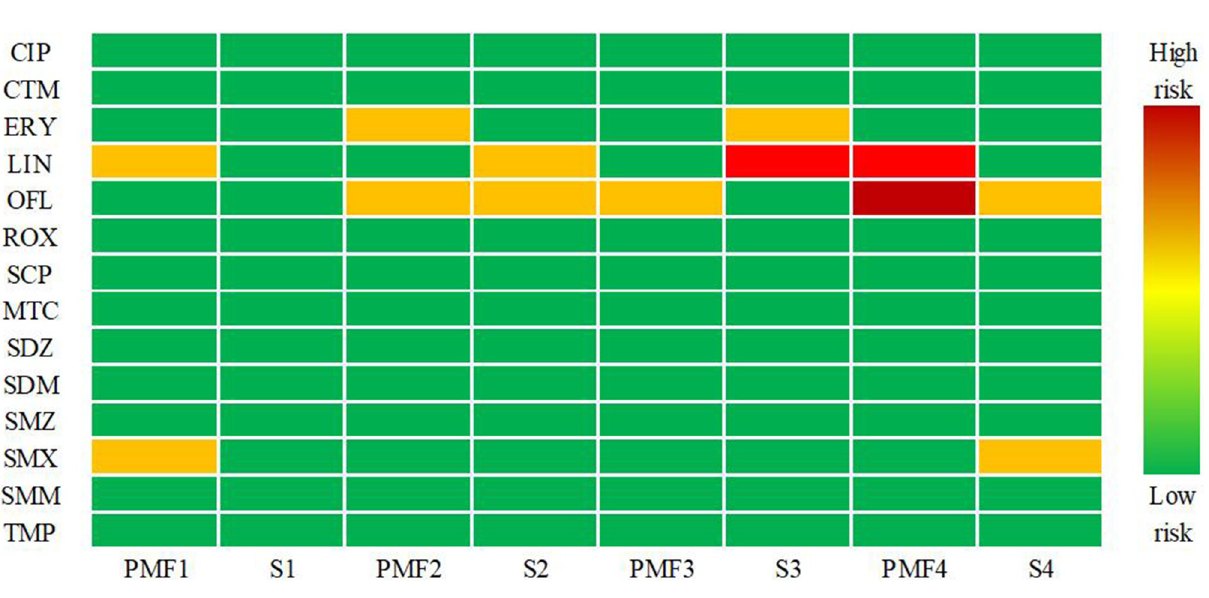
Fig 5. RQs for antibiotics in water samples of PMFs and receiving water